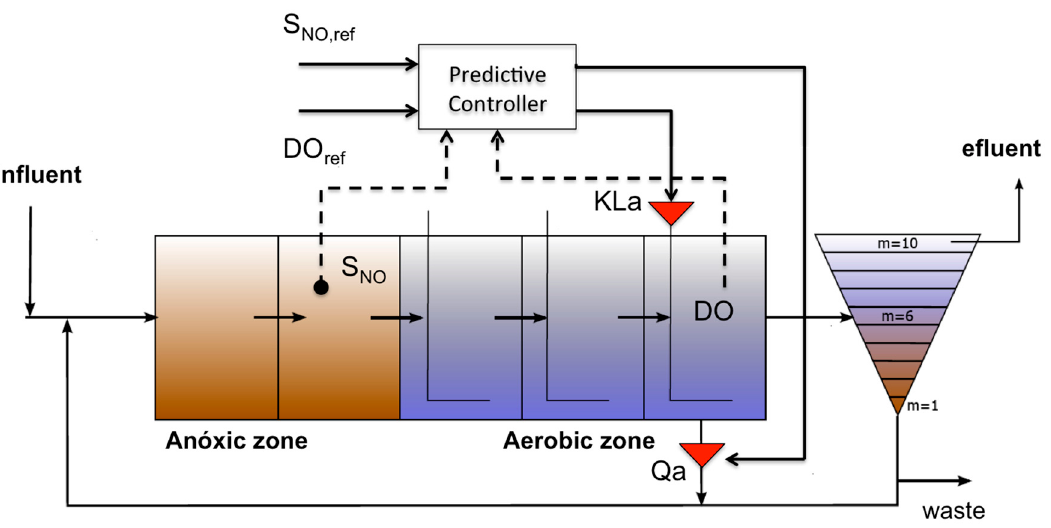
Figure 3. Proposed control strategy in the BSM1 layout indicating the measured variables: nitrates concentration in the second anoxic reactor, oxygen concentration in the last aerobic reactor, and the manipulated variables Qa and KLa .